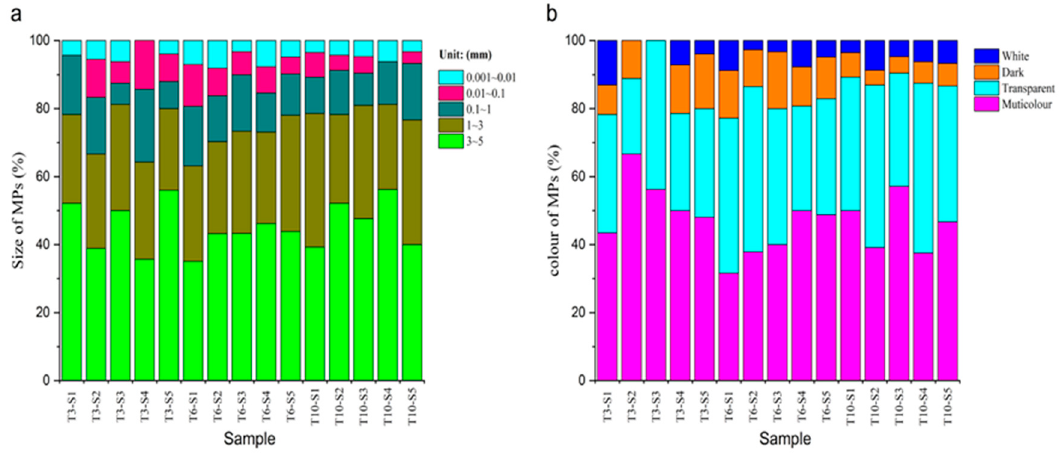
Figure 4a. This indicated the gradual decomposition of large-sized plastics to small- sized MPs.